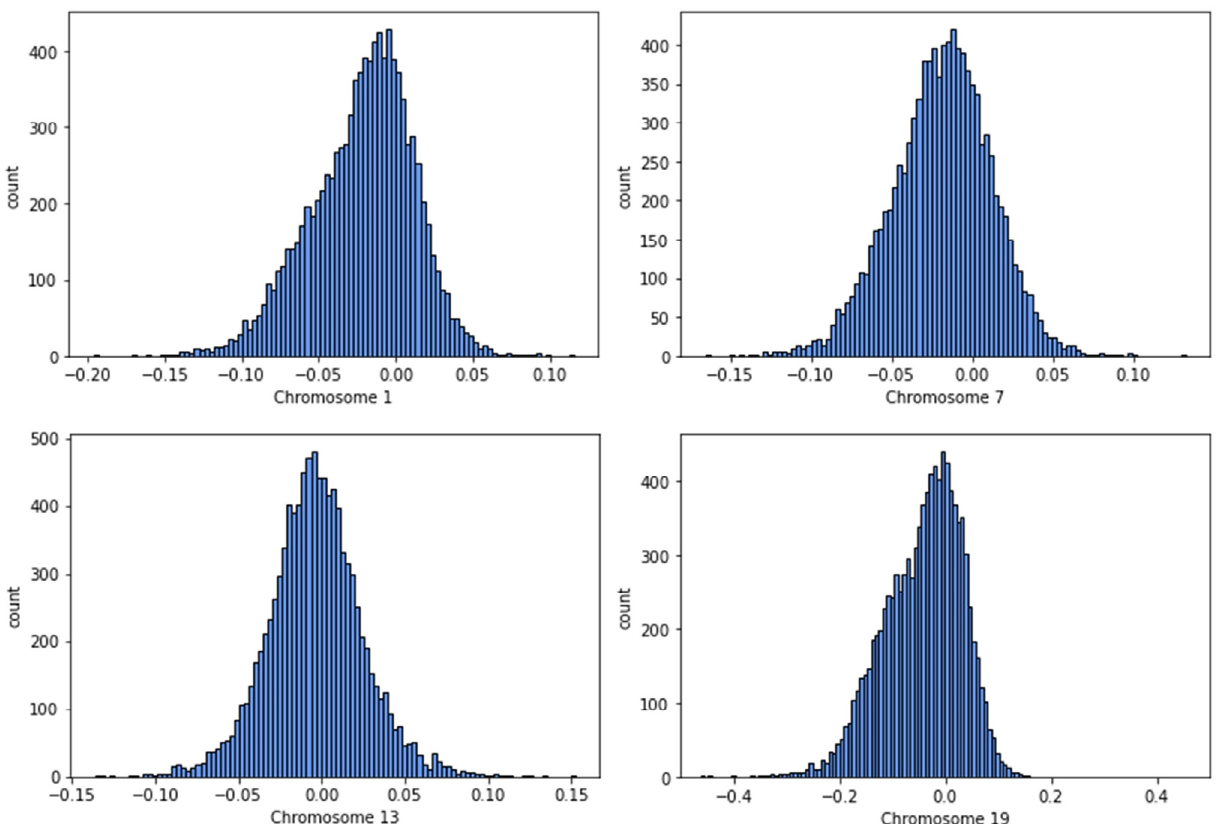
Figure 1. This fi gure shows a histogram of chromosome-scale length variation measurements of chromosomes 1, 7, 13, and 19 for 10,000 people in the NIH All of Us dataset. “Chromosome length” is measured by averaging calibrated intensity measurements taken from SNP arrays for many SNPs located on each of the four chromosomes. These calibrated intensity measurements are representa- tive of local copy number. Chromosomes can have many deletions, insertions, and translocations that a ff ect copy number. The values measured in log_2(Ratio Units) represent the overall length of the chromosome, where a value of zero indicates the nominal average chromosome length. By